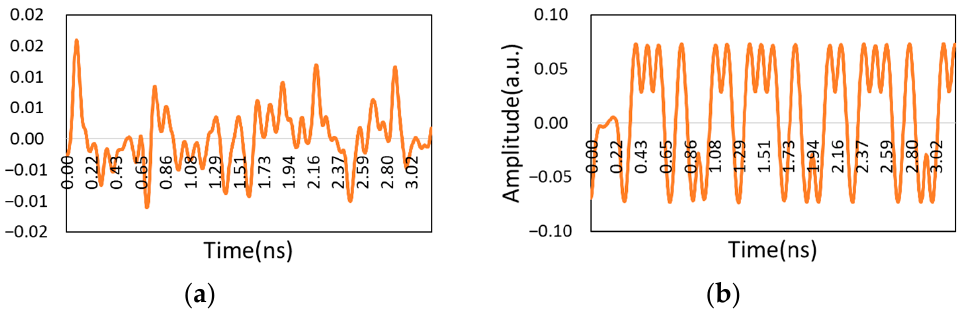
Figure 11. Demodulation waveform: ( a ) Demodulation waveform with π /2 phase difference; ( b ) Demodulation waveform after phase compensation.